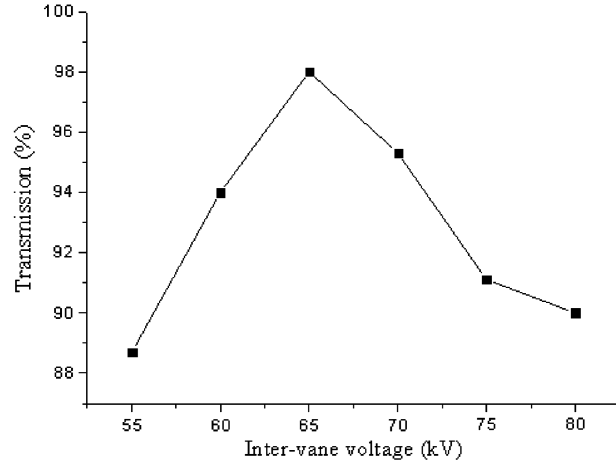
FIG. 14. Energy spectrum of the coupled RFQ-SFRFQ cavity.